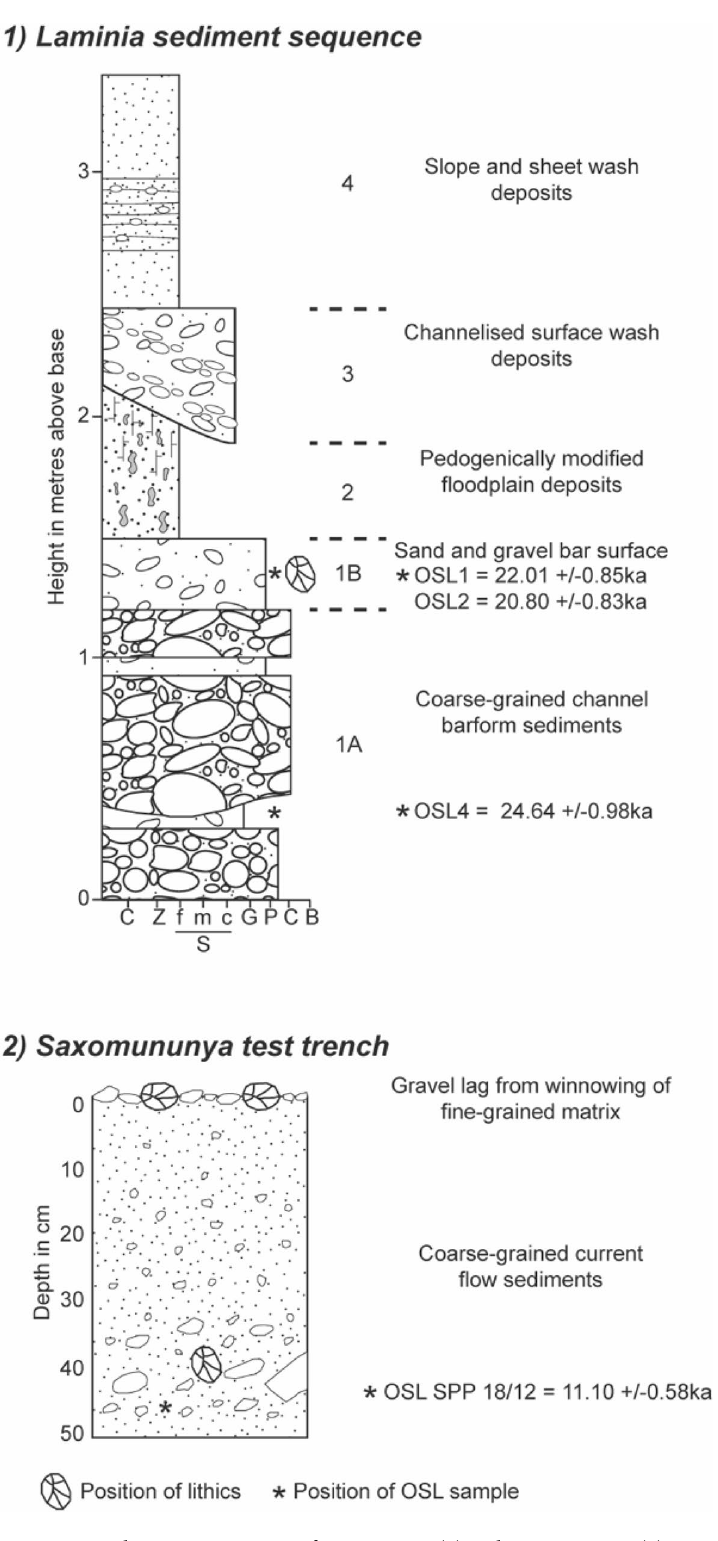
Figure 2. Sedimentary sequences from Laminia (1) and Saxomununya